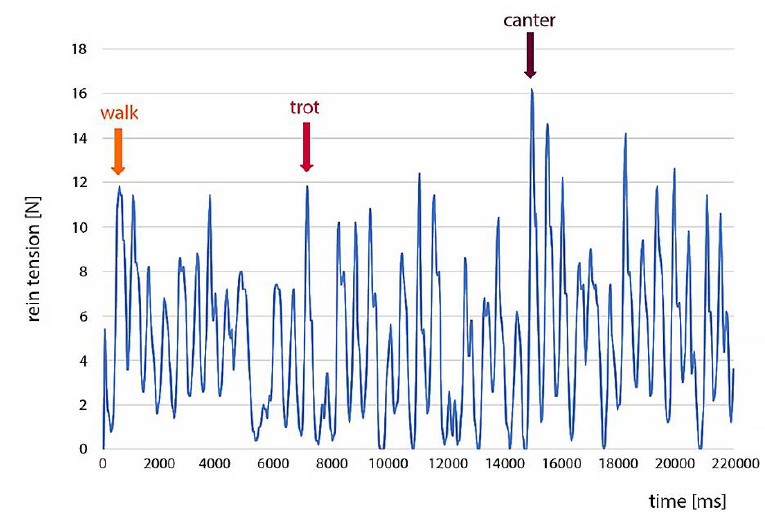
Figure 3. Raw data of a rein tension measurement while riding on the left hand; the data show an oscillating pattern for each gait; the first arrow indicates the start of the walk-phase, the second arrow indicates the transition from walk to trot, and the third arrow indicates the transition from trot to canter.